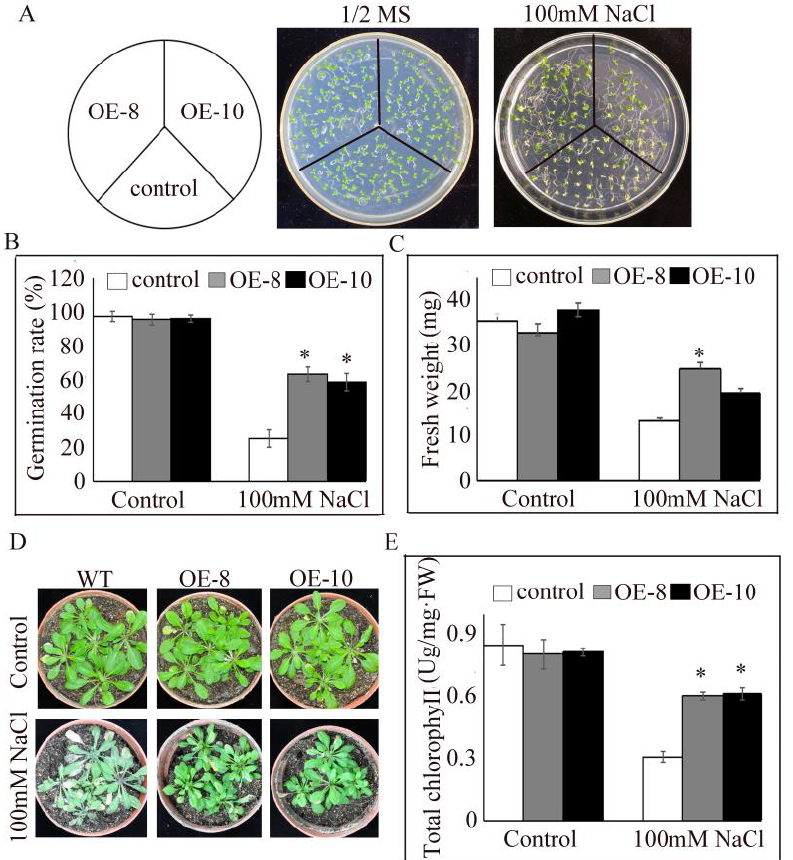
Figure 5. Analysis of salt tolerance in PtrDHN-3 -overexpressing Arabidopsis plants. ( A ) Seed germination in the transformed and wild-type (WT) lines under control (1/2 MS) and salt stress (100 mM NaCl) conditions. ( B ) Seed germination rates, and analyses of ( C ) fresh weights, ( D ) growth phenotypes, and ( E ) chlorophyll contents. WT and OE Plants were grown on 1/2 MS medium (control) or 1/2 MS medium plus 100 mM NaCl for two weeks for analysis of seed germination rates. For analysis of fresh weights, WT and OE plants germinated on 1/2 MS medium plates for five days were transferred to 1/2 MS medium plates with or without 100 mM NaCl. Measurements were obtained after continuous cultivation for seven days. For observations of growth phenotypes, 4-week-old T3 transgenic and WT Arabidopsis seedlings grown in pots were treated with 100 mM NaCl solution for 10 days then their phenotypes were photographed. The chlorophyll content of leaves was measured. Asterisks indicate a significant difference compared with the WT plants at p < 0.05. Under normal growth conditions, Diaminobenzene (DAB) and Nitrotetrazolium Blue chloride (NBT) staining revealed similar accumulation of H 2 O 2 and O 2 · - between the transgenic and WT Arabidopsis plants (Figure 6A). However, under salt stress conditions, accumulation of H 2 O 2 and O 2 - decreased in the transgenic compared with WT plants, especially at 12 h, and blue and brown staining were detected in the